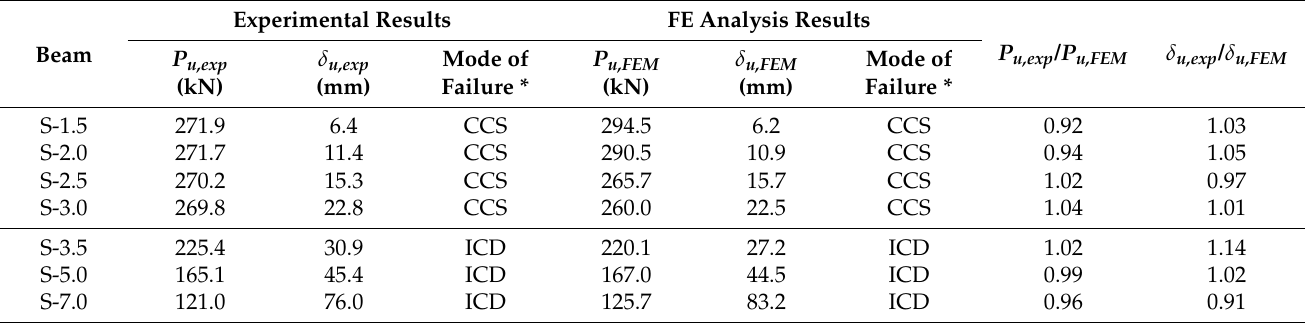
Table 6. Ultimate capacities and failure modes obtained by experiments [6] and FE